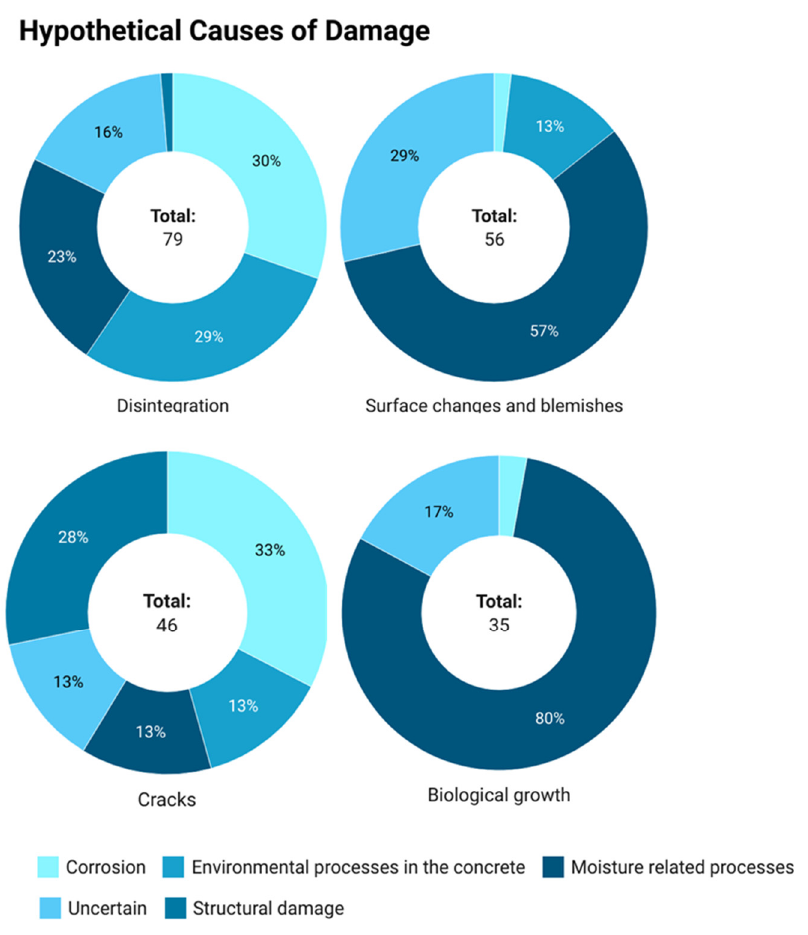
Figure 5. Hypothetical causes of damage per type of damage Figure 5 . Hypothetical causes of damage per type of damage group.